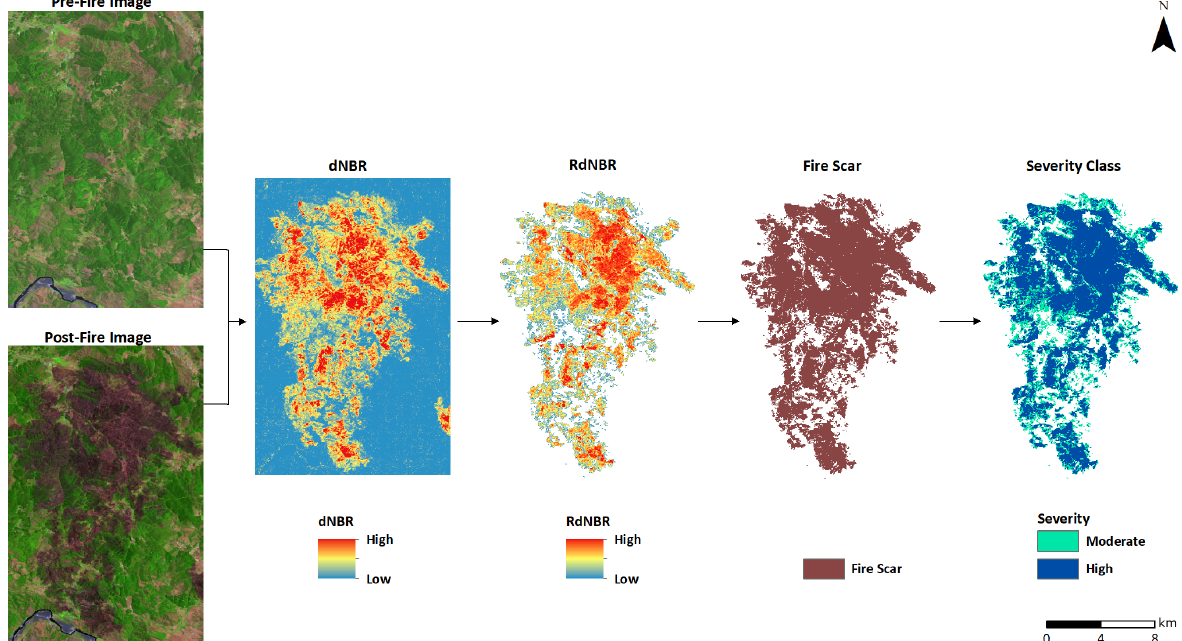
Figure 3. The database content for each reconstructed fire scar. See Table 1 for details on the dNBR and RdNBR. The illustrated event is from the Maule region and occurred in 2014.